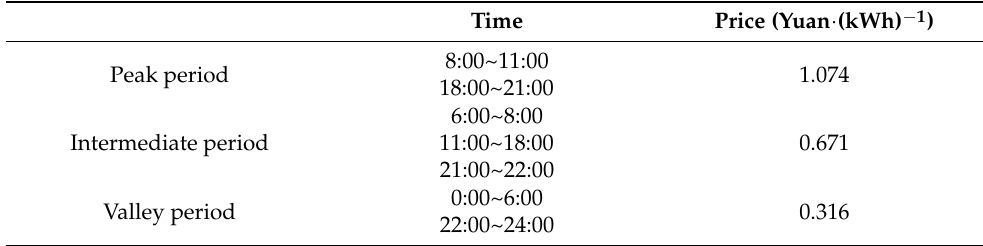
Table 2. Cost, maintenance cost, operational efficiency, and life of main equipment.